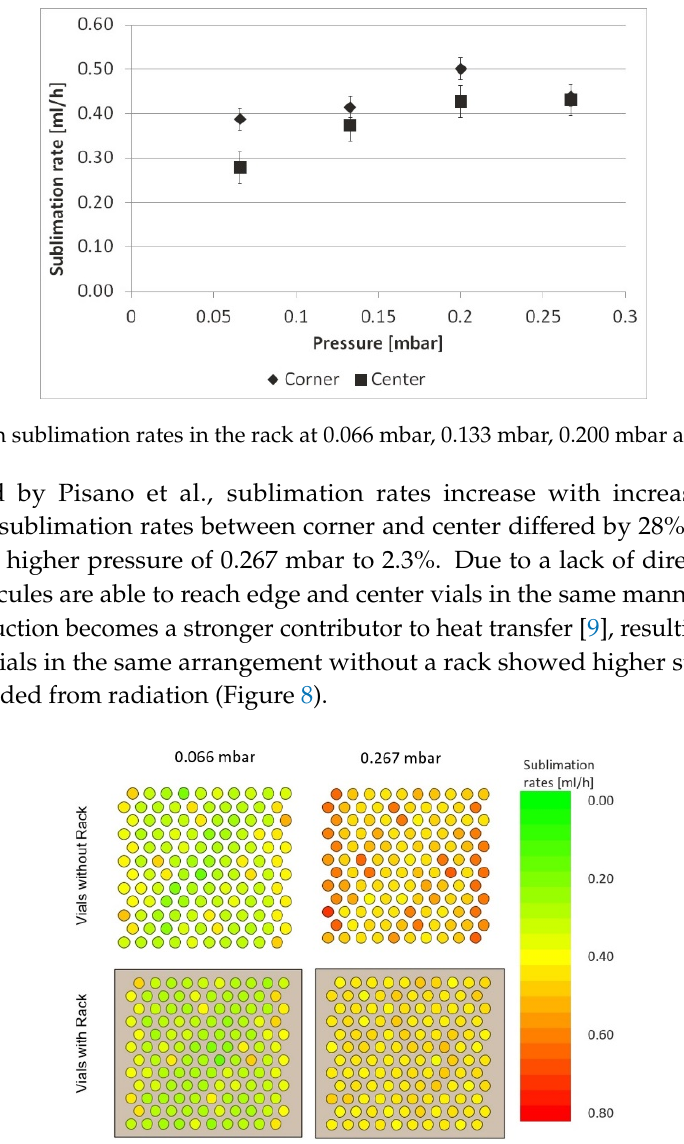
The difference between corner and center vials was 31% at 0.066 mbar, which decreased to 22% 0.267 at 0.267 mbar.